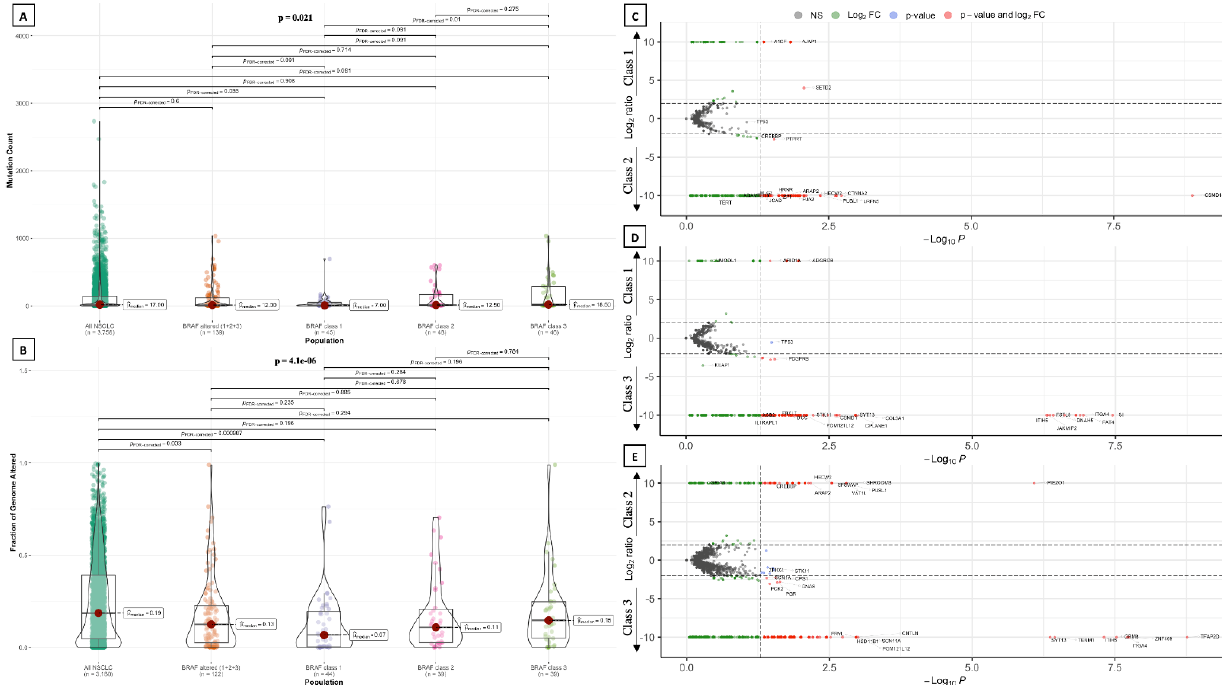
Figure 5. Violin plots show a comparison in terms of mutation count ( A ) and fraction of genome altered ( B ) among the three BRAF functional classes, showing a significantly higher mutation count in patients harboring class 3 alterations compared to those with class 1 alterations. Volcano plots comparing gene co-alteration frequency in patients harboring BRAF alterations of class 1 vs. class 2 ( C ), class 1 vs. class 3 ( D ), and class 2 vs. class 3 ( E ). NS: not significant. 3.2.3. Tumor Mutational Burden, Mutation Count and Fraction of Genome Altered Median tumor mutational burden (TMB) was 7.83 mut/Mb (95% CI, 6.85 – 8.97) in pa- tients with any BRAF alteration ( n = 236). In tumors with BRAF alterations of a known functional class ( n = 139), median TMB did not significantly differ from that of all NSLCL patients (6.05 mut/Mb vs. 5.30 mut/Mb, p = 0.209) (Figure 2B). Instead, a statistically sig- nificant difference was found between NSCLC harboring distinct classes of BRAF altera- tions ( p < 0.001). In particular, median TMB was significantly lower in tumors with BRAF class 1 alterations (median TMB = 3.91 mut/Mb) than in those harboring class 2 (median TMB = 6.73 mut/Mb, p = 0.004) and class 3 (median TMB = 10.57 mut/Mb, p < 0.001) alter- ations, as well as compared to that of NSCLC with BRAF alterations of any known func- tional class ( p = 0.006) and unselected NSCLC ( p = 0.03) (Figure 2B). Class 3 alterations were associated with the highest median TMB, even compared to BRAF alterations of any known functional class ( p = 0.006) and unselected NSCLC ( p < 0.001) (Figure 2B). Total mutation count (MC), defined as the total number of mutations found in each patient’s sample, was not significantly different between NSCLC patients with BRAF alterations of a known functional class and unselected NSCLC patients (Figure 5A). However, MC was significantly different among patients carrying distinct BRAF alterations classes, and was significantly higher in patients harboring class 3 alterations compared to those with class 1 alterations ( p = 0.01) (Figure 5A). Likewise, the fraction of genome altered (FGA) was significantly lower in patients with BRAF alterations of a known functional class com- pared to the total of NSCLC patients, but did not show significant differences among the three BRAF classes (Figure 5B).